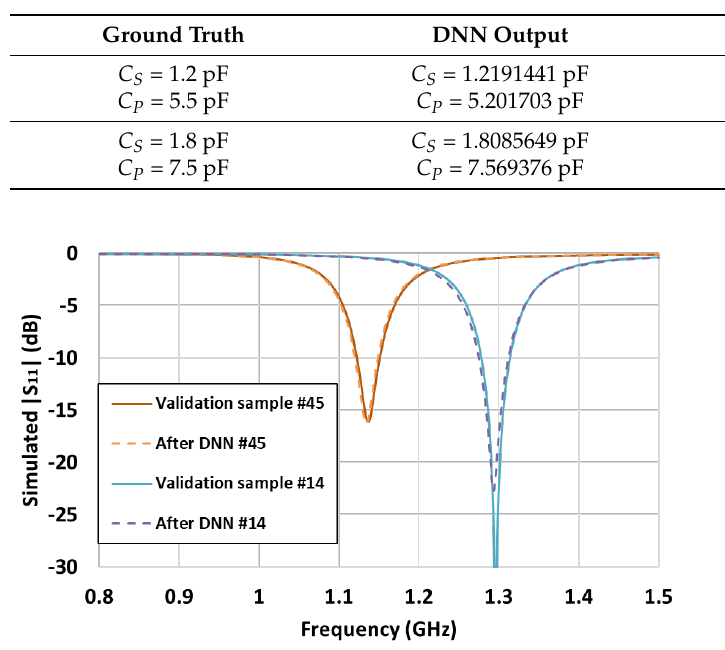
Figure 8. Comparison of ideal S 11 waveform with that obtained from DNN results. Machine learning has been applied for impedance matching using neural networks, as listed in Table 5. However, those applications consider frequencies in the order of meg- ahertz, which is relatively lower than the gigahertz band required for antenna impedance matching. Moreover, those applications are limited to implementable impedance patterns. On the other hand, the proposed DNN can perform antenna impedance matching in the gigahertz frequency band. Unlike conventional methods, it uses only the magnitude in- stead of the complex impedance value to learn antenna matching values. Moreover, rea- sonable capacitor values for antenna impedance matching can be obtained even for S 11 magnitudes that cannot be implemented in practice. In reference papers [20,21], matching values for ideal inputs were not presented.